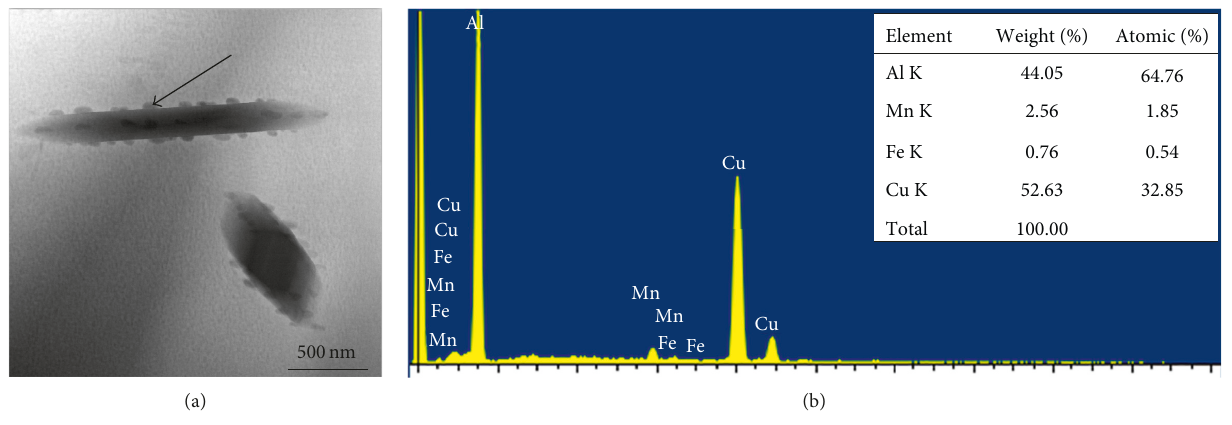
Mn particles in the A 2 alloy T6 tempered (a) and its